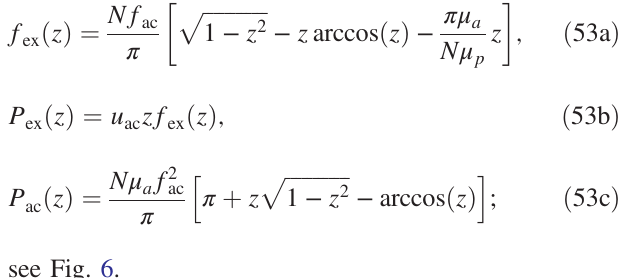
TABLE I. Thermodynamic characterization of the extraction of work for the idealized velocity filter in a setting with a single active particle ( N ¼ 1 ) and in the limit of many active particles. Listed are the maximal extracted power per active particle (along with the maximizing parameters f and μ p ), the active efficiency ex at maximum power η (cid:4) , and the maximal active efficiency η . max Note that, in the mean-field theory, the maximum power is independent of the mobilities μ p;a , as long as their ratio is well above 1 =N